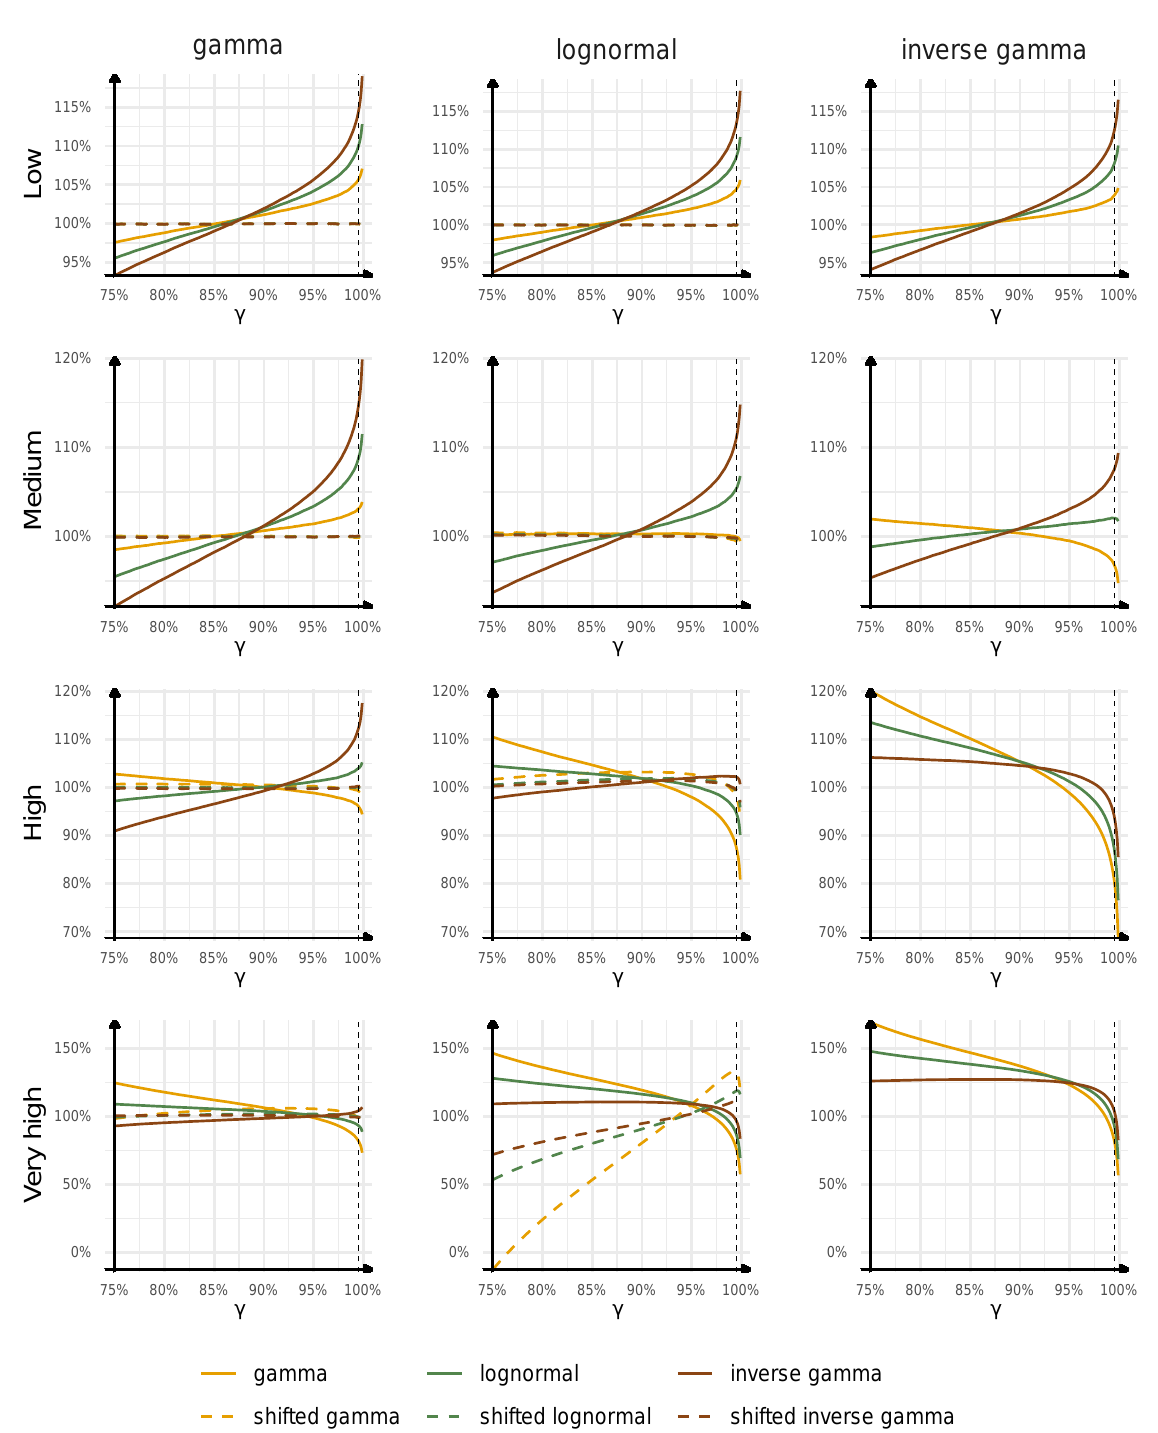
Figure 5. The ratios of Value-at-Risk measures for the outstanding loss estimated with parametric distribution and empirical distribution as a function of the confidence level—the case with the estimation error and the one-year